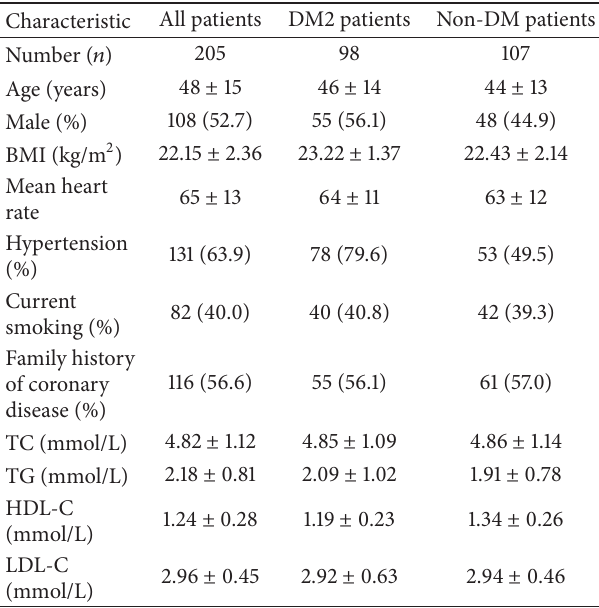
Table 1: Basic characteristics.